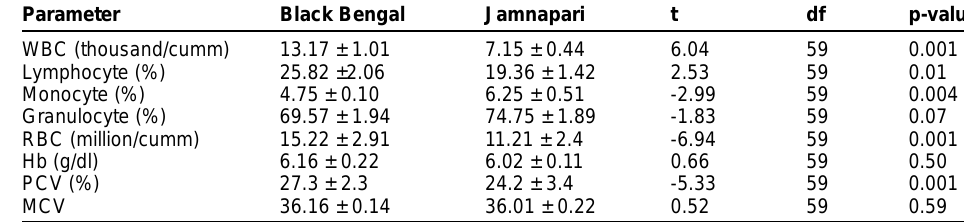
Table-4. Comparative biochemical status of Black Bengal and Jamnapari goat Parameter